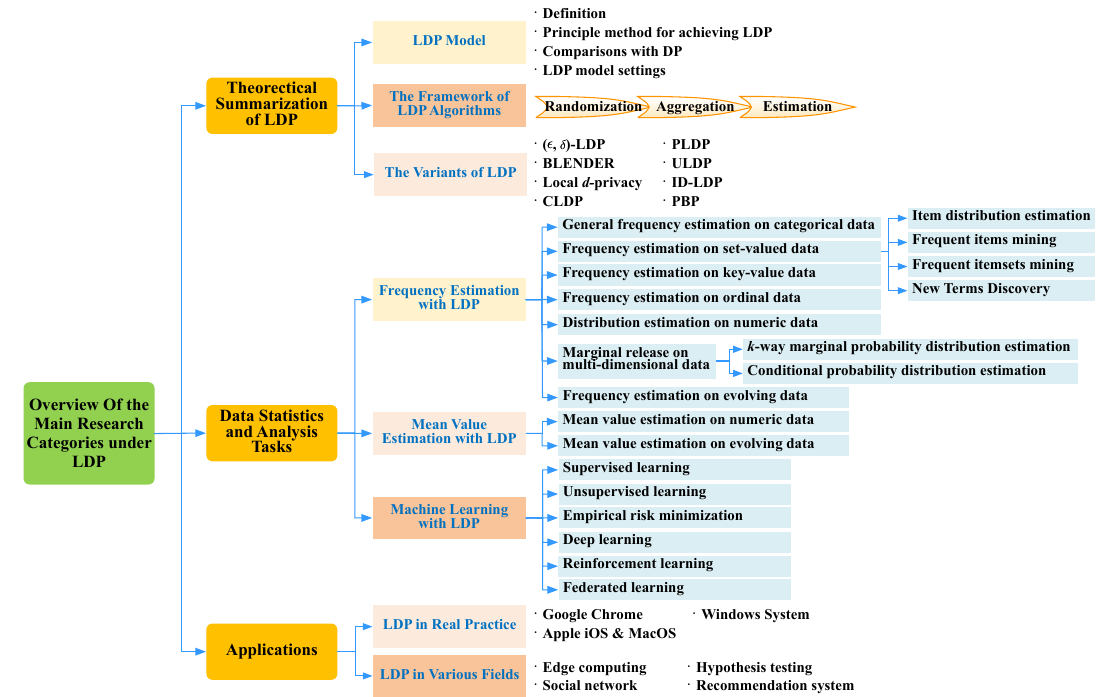
Figure 1. An overview of the main research categories with